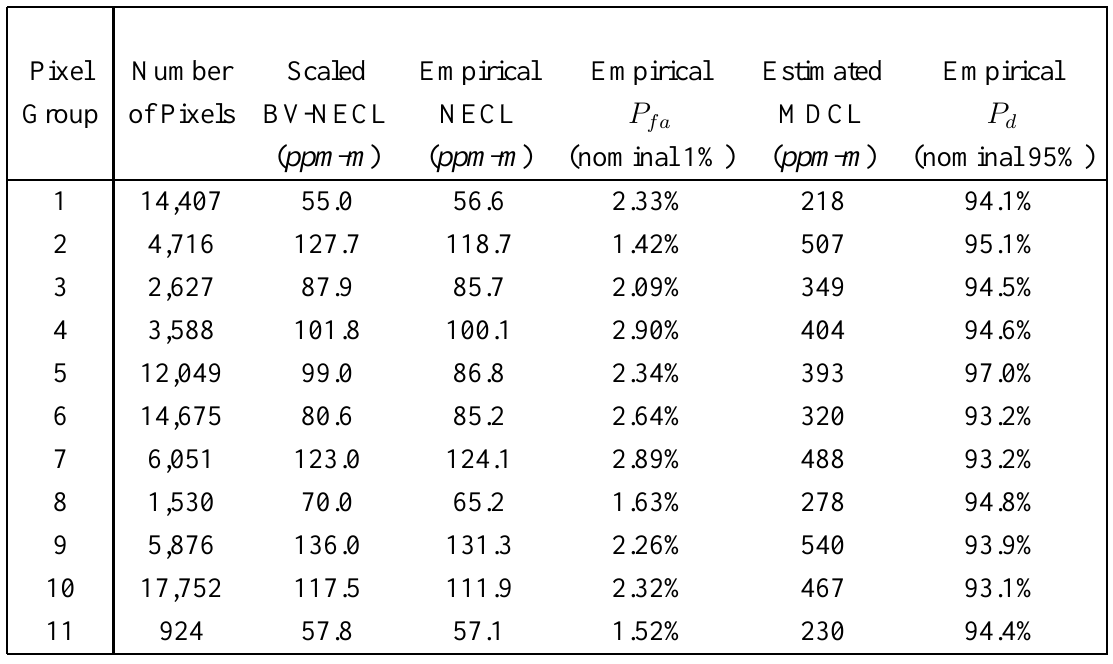
Table 2. Comparison of estimated and empirical detectability for Gas 7 using +5 ◦ K plume